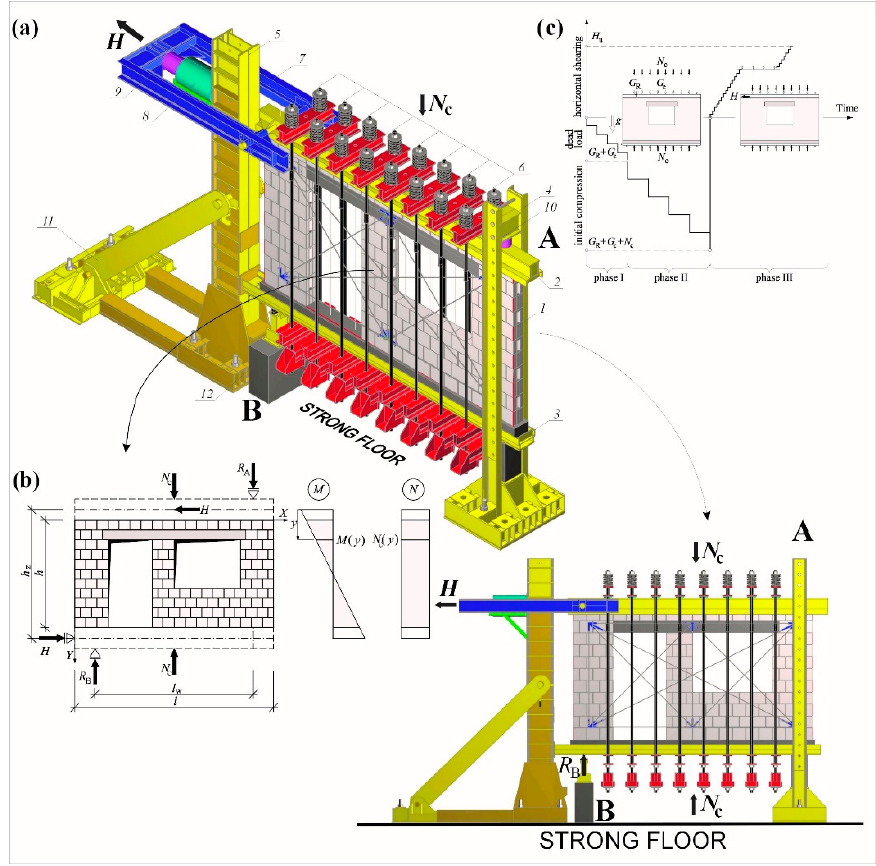
Figure 5. (a) Test stand, (b) static scheme, and (c) sequences of loads. Figure 5. ( a ) Test stand, ( b ) static scheme, and ( c ) sequences of